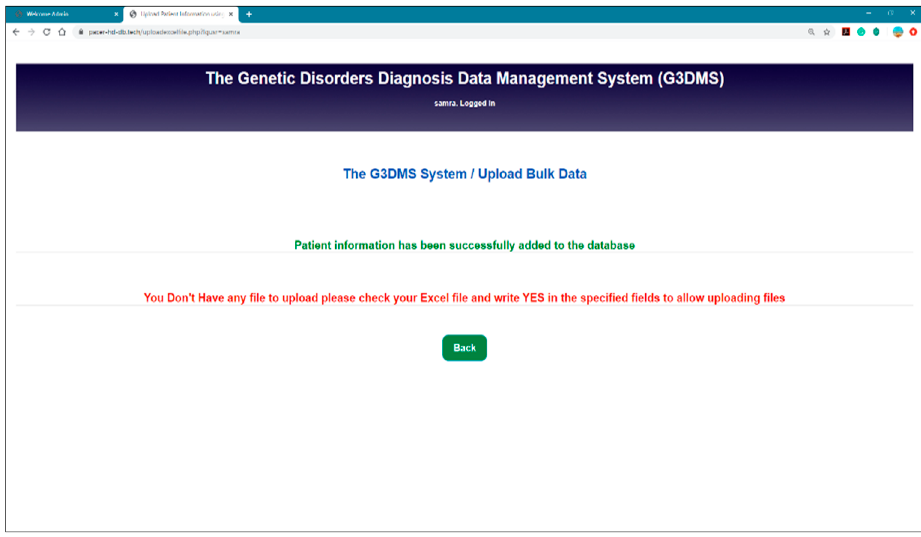
Figure 20. Confirmation messages.